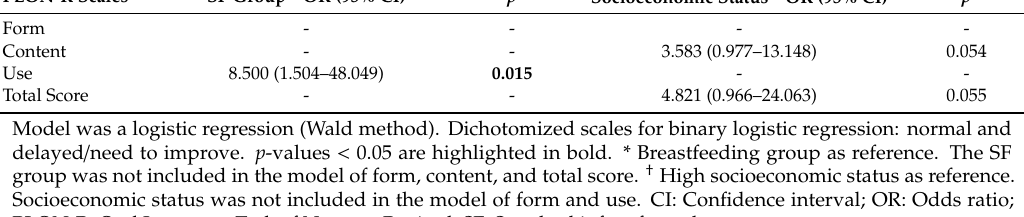
Table 4. E ff ects of COGNIS groups and socioeconomic status on language outcomes at four years old. PLON-R